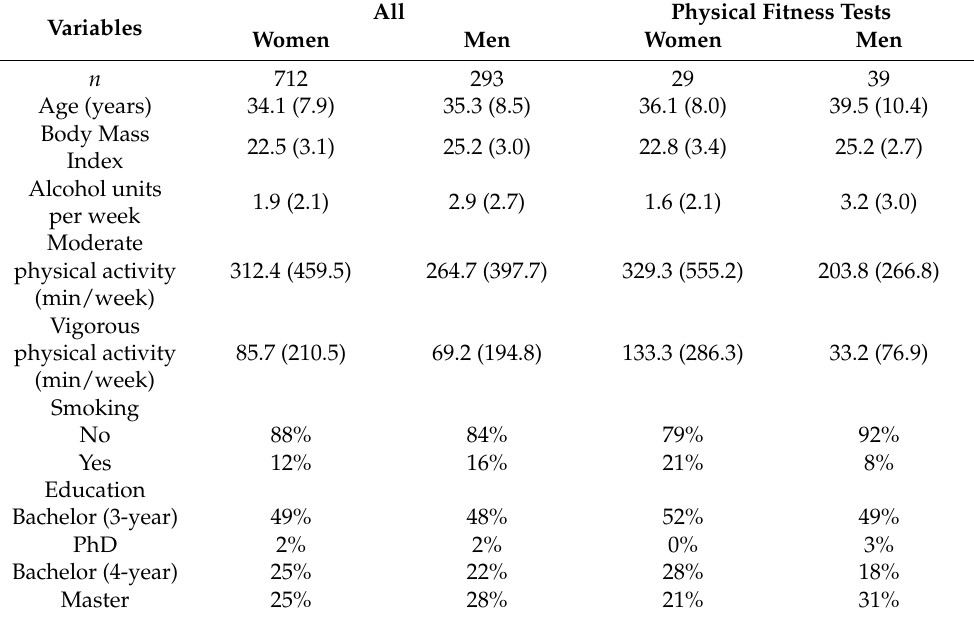
Table 1. Demographics, lifestyle and education of women and men (all as well as the subgroup with physical fitness